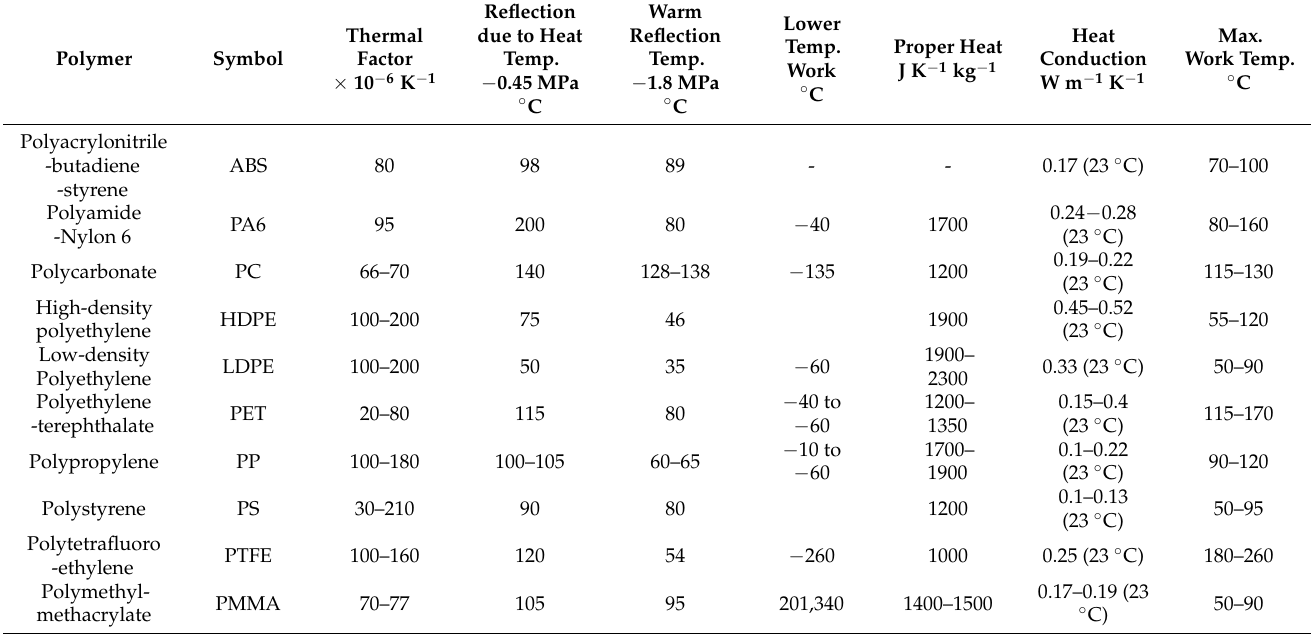
Table 1. Selected thermal properties of plastics. Made based on [7].